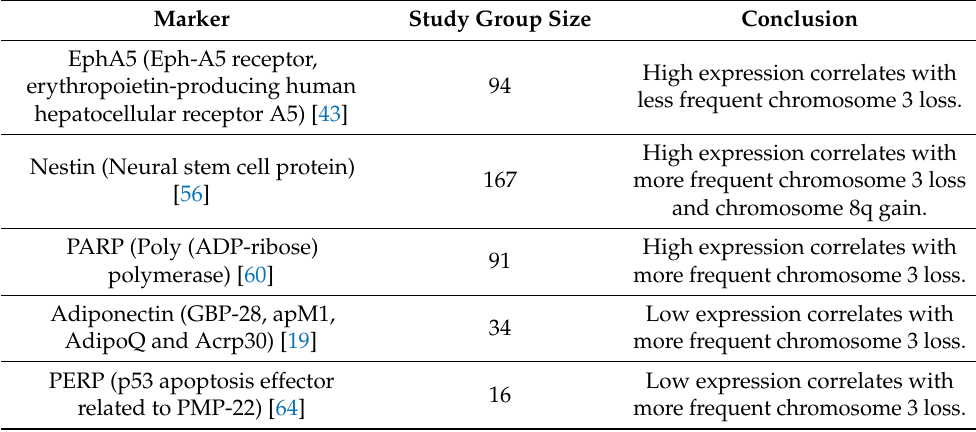
Table 6. Summary of markers whose expression is related to chromosome status.